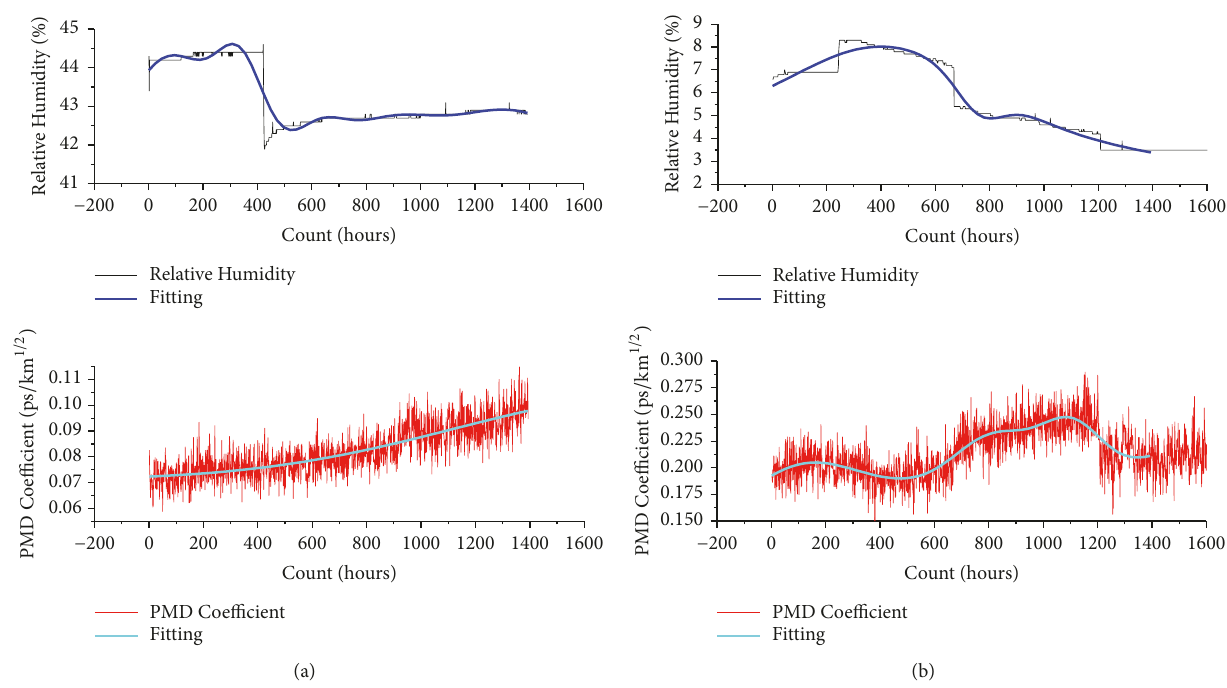
Figure 4: (a) Relative humidity (black) with fitting (blue) and PMD coefficient (red) with fitting (cyan) for highland climate in Mau-Summit area. (b) Relative humidity (black) with fitting (blue) and PMD coefficient (red) with fitting (cyan) for semi-arid climate in Sultan Hamud